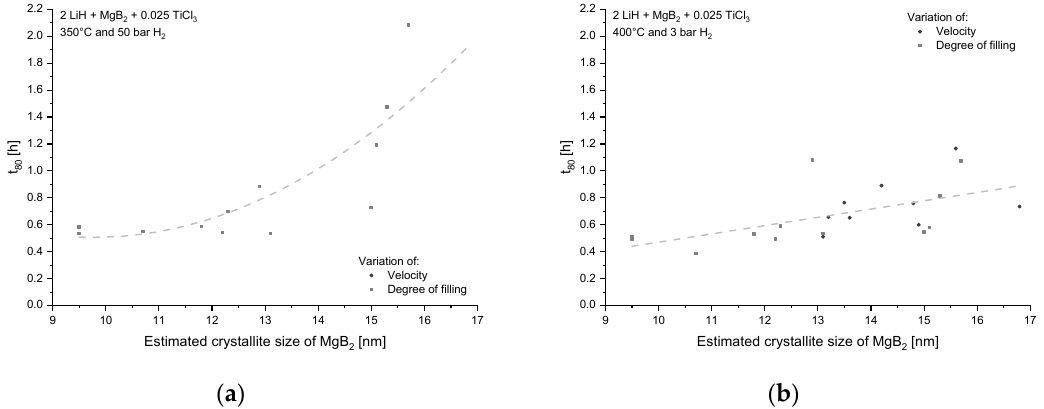
Figure A4. Kinetic behavior as a function of the calculated MgB 2 crystallite size after processing for ( a ) absorption and ( b ) desorption.